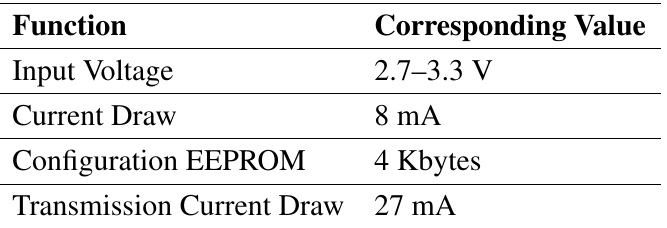
Table 8. Mica2 mote specification [50].